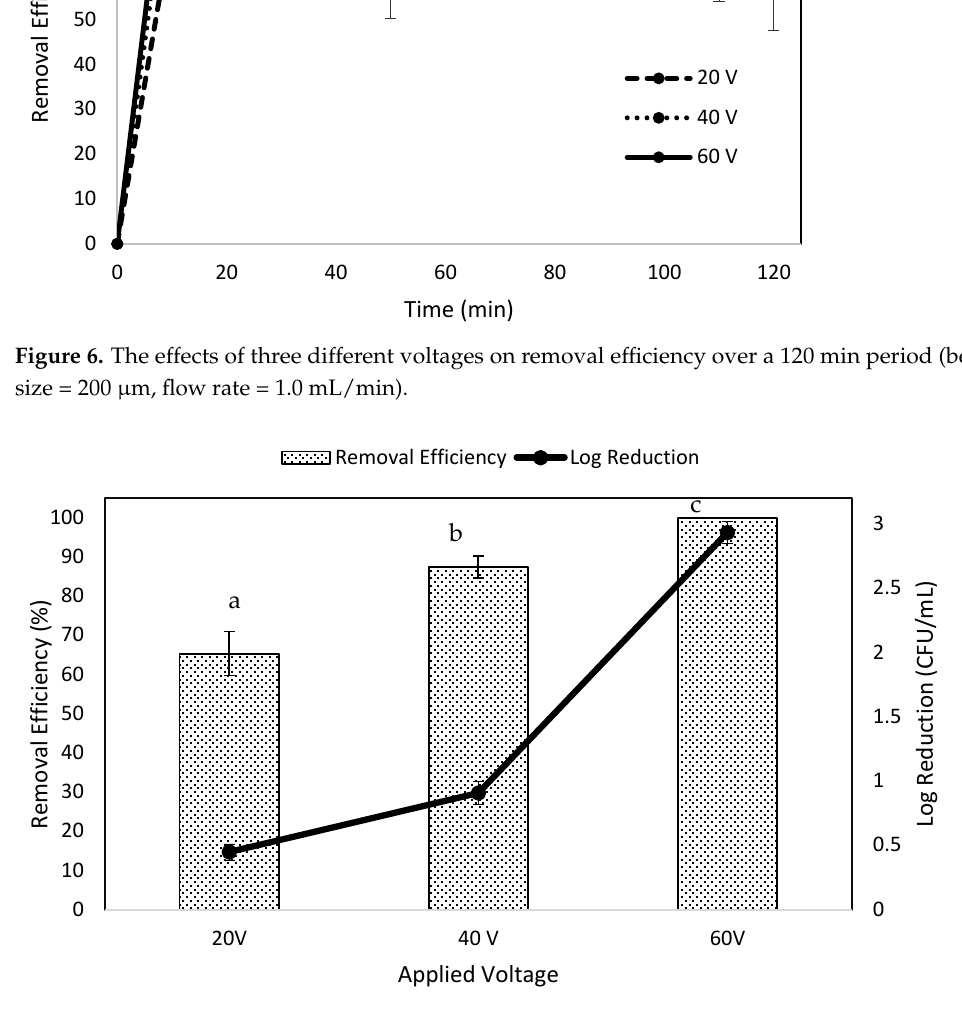
Figure 7. Comparison of the average removal efficiency and log reduction when three different voltages are applied. Different letters indicate significant differences among the applied voltages ( p < 0.05).